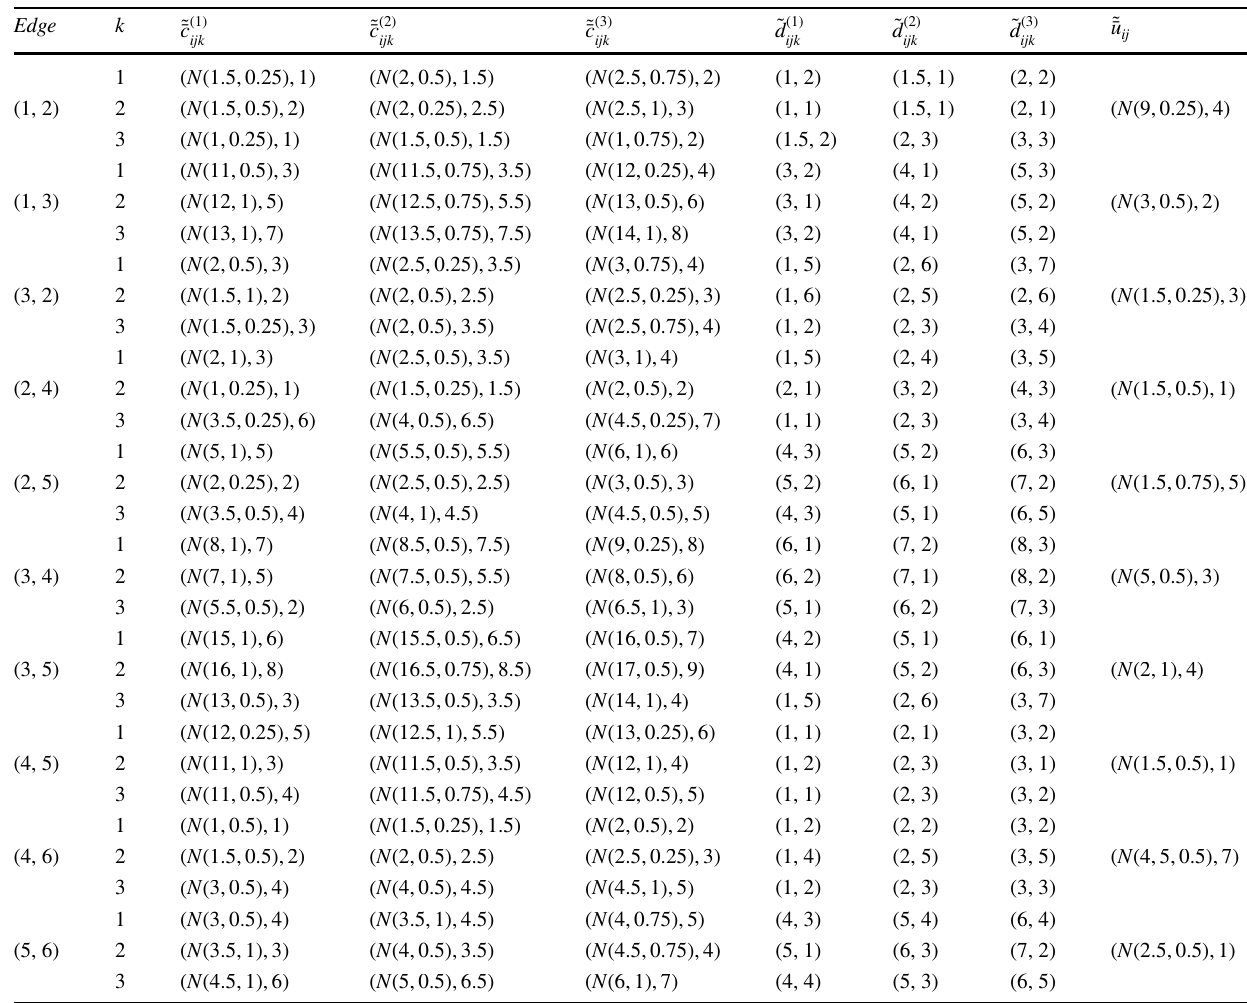
Table 6 The related data of the Example 1